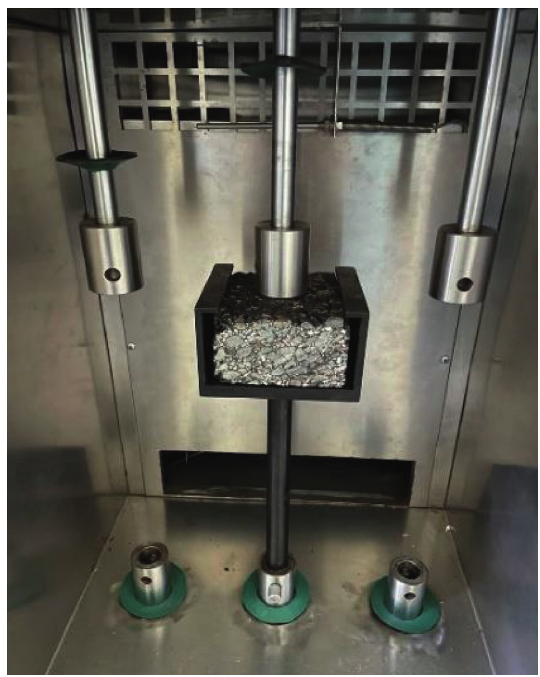
Figure 5: Bond strength test